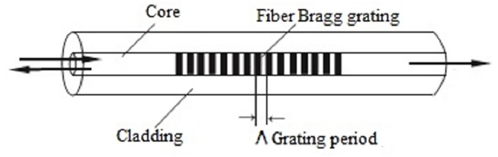
Figure 3. The structure of fiber Bragg gratings (FBGs).